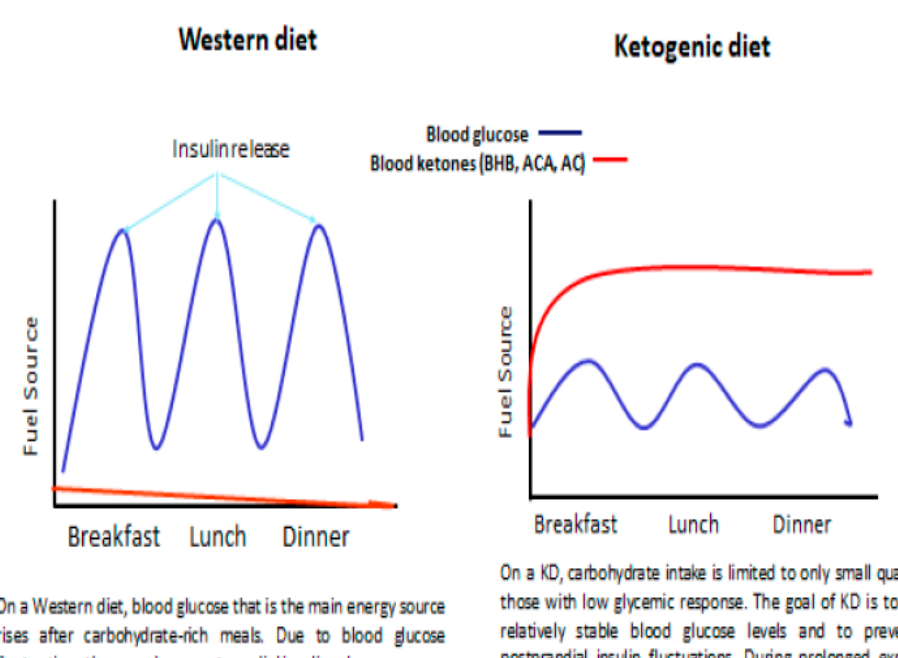
Figure 2. Di ff erences in primary fuel sources between a typical Western diet and a KD. Visual depiction is taken from practice paper of the Academy of Nutrition and Dietetics [19], KD—Ketogenic